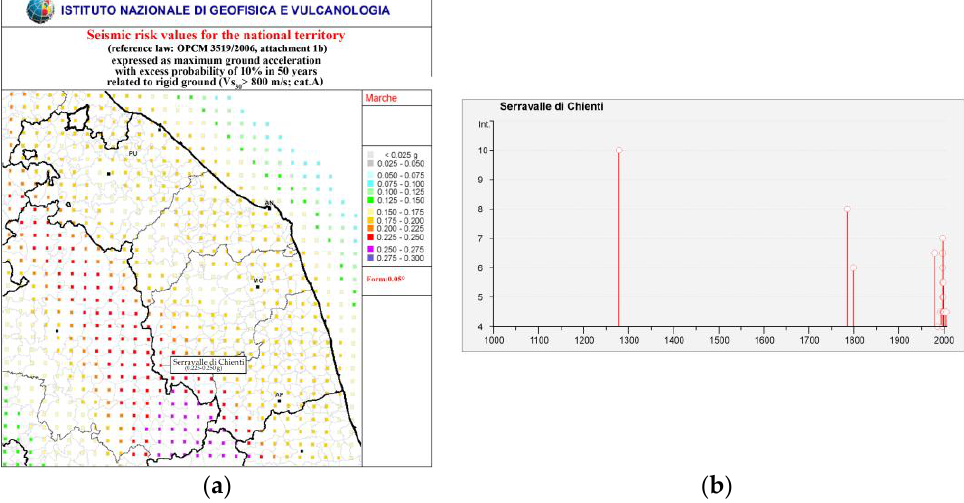
Figure 4. ( a ) Marche seismic hazard map. Serravalle di Chienti’s value of peak ground acceleration (PGA) (% g) is pointed out [43]. ( b ) The histogram represents in the x axis the year of occurrence of the earthquake episode and on the y axis the intensity value [44].